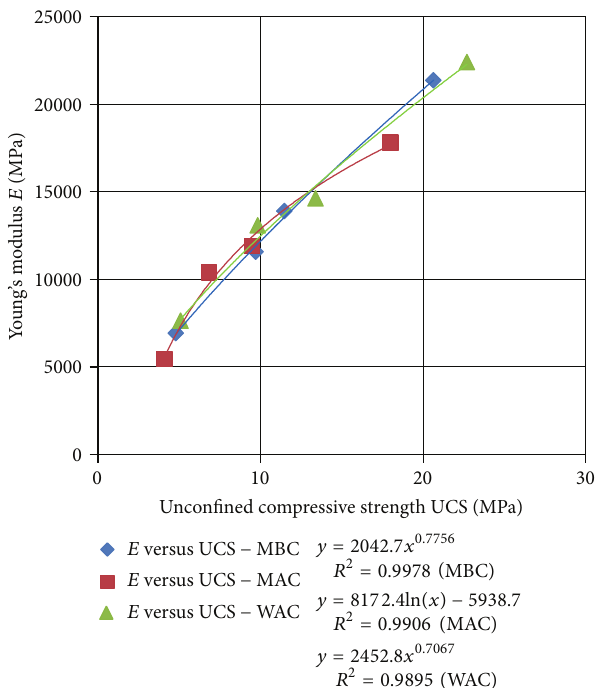
Figure 13: Relationship between Young’s modulus ( 𝐸 ) and uncon- fined compressive strength (UCS) for increasing cement content.